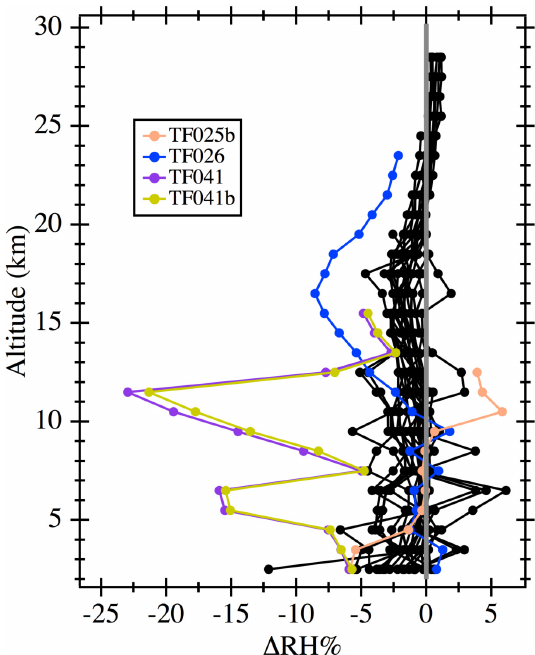
Fig. 15. Profiles of differences between RH measured directly by RS92 sondes and RH calculated from frost point hygrome- ter measurements using coincident iMet temperature data (RS92- FP IMET ). Each of the four anomalous profiles identified here were also anomalous in Fig. 14. The mean ± standard deviation of 1 RH for the majority of difference profiles is − 1.2 ± 1.5%RH, portray- ing a standard deviation range that fits wholly within the RS92 man- ufacturer’s ± 5%RH total measurement uncertainty range.